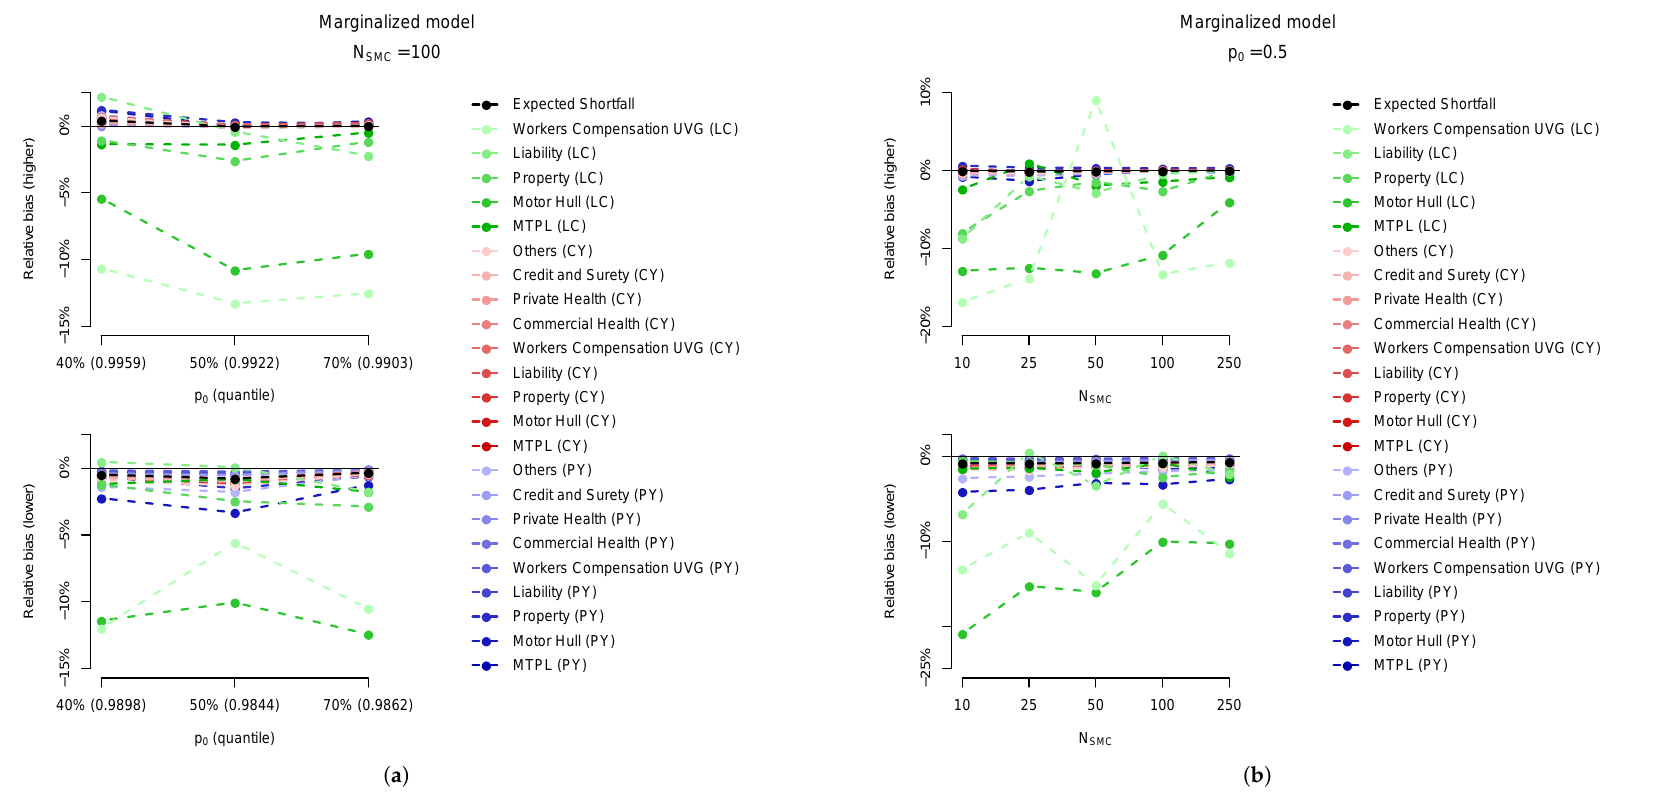
Figure 14. Relative bias in the marginalized model as a function of ( a ) the parameter p 0 and ( b ) the sample size in the SMC sampler, N SMC